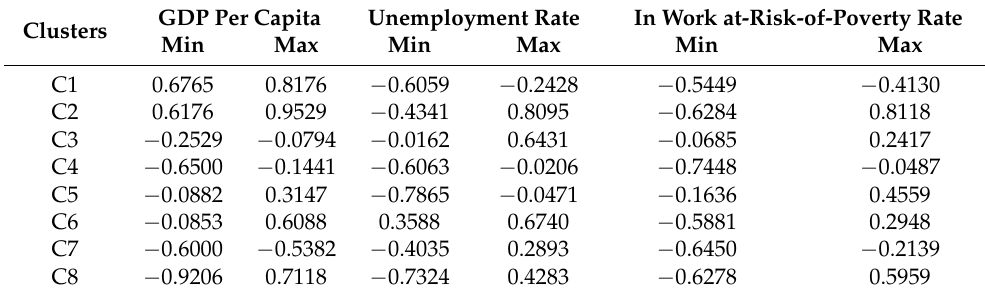
Table 3. Spearman’s rank ρ coefficients between the values of the synthetic COPRAS measure and values of indicators. Source: own